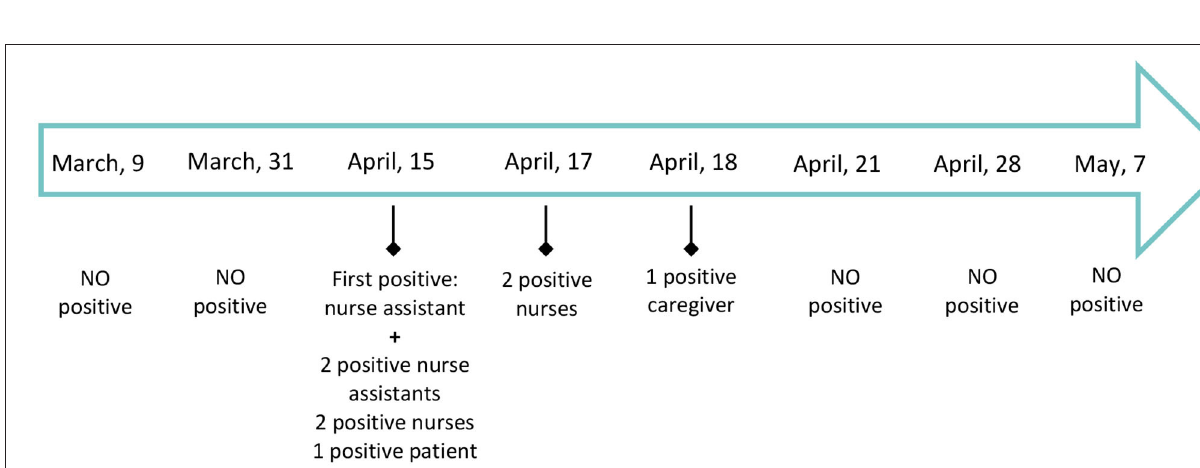
Frontiers in Medicine | www.frontiersin.org